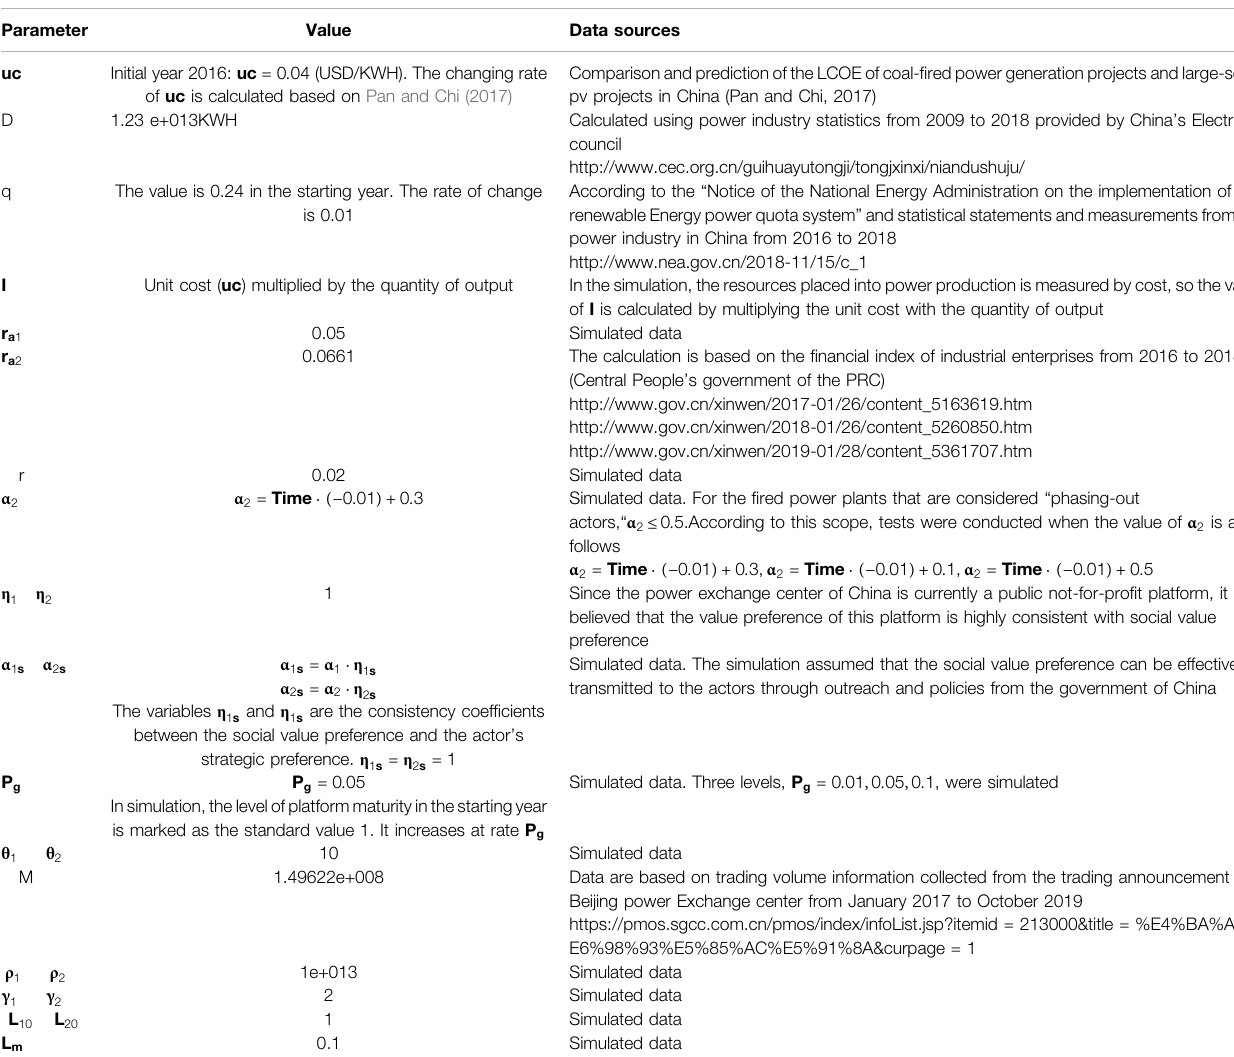
TABLE A1 | Value of the parameters in numerical